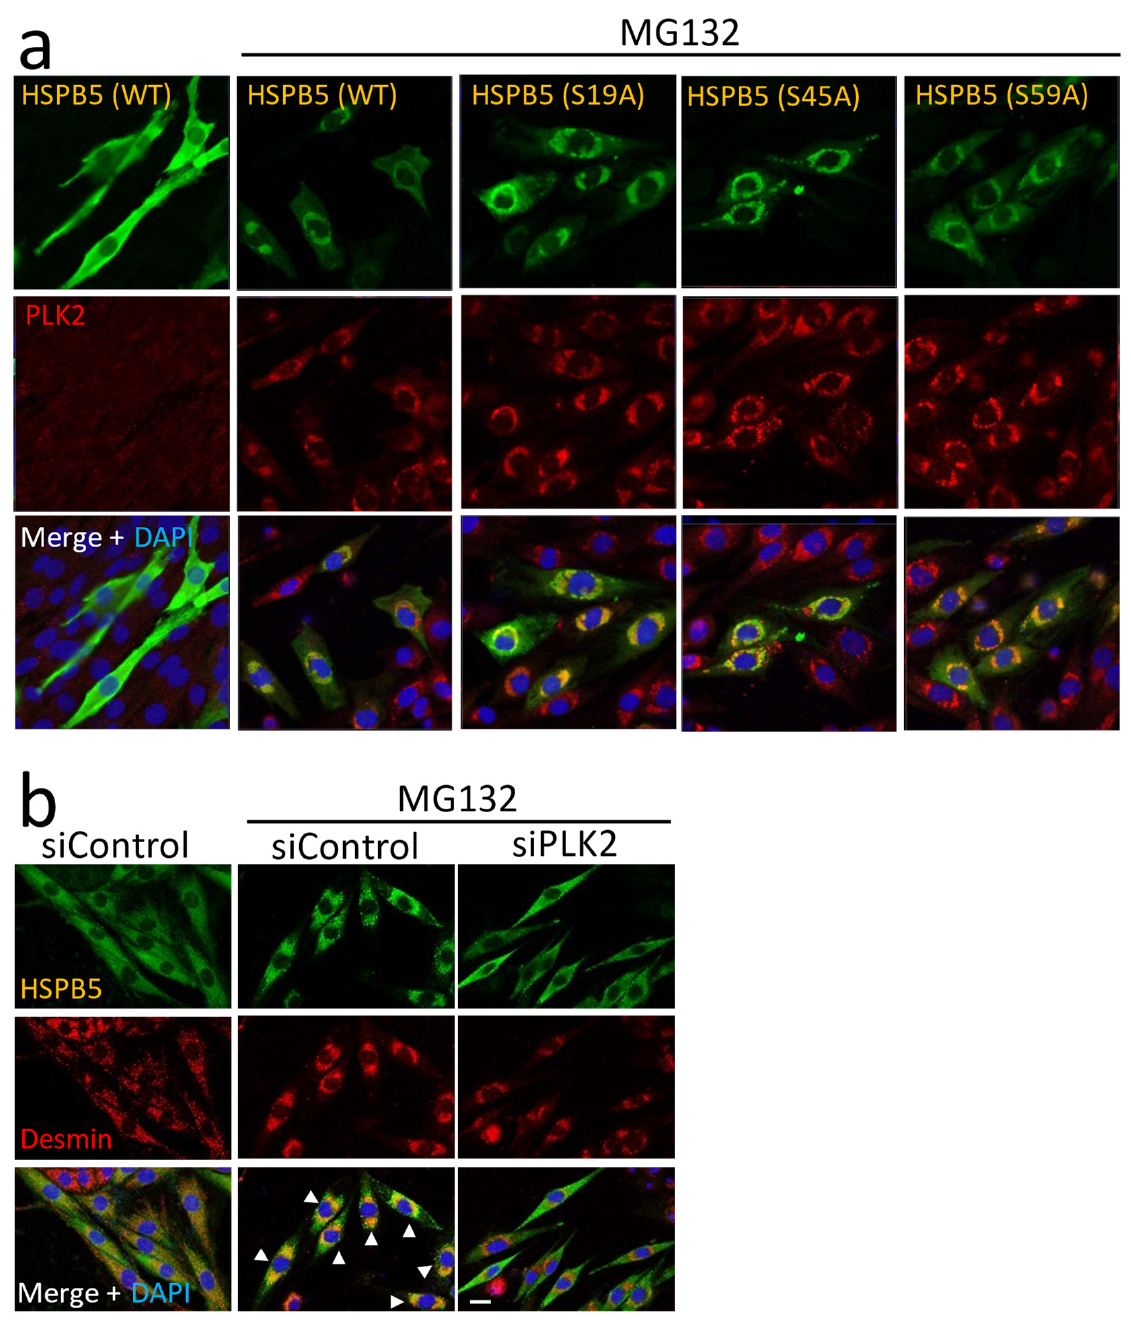
Figure 6. Relationship between phosphorylation and subcellular localization of HSPB5. ( a ) Localization of overexpressed recombinant HSPB5 and endogenous PLK2. After 5 µ M MG132 treatment (24 h), FLAG-tagged HSPB5 and endogenous PLK2 in undifferentiated L6 cells were immunofluorescently stained with anti-tag and anti-PLK2 antibodies. ( b ) Effect of PLK2 on localization of HSPB5 and desmin protein. Endogenous HSPB5 and desmin were immunofluorescently stained with anti-HSPB5 and anti-desmin antibodies. Undifferentiated L6 cells were transfected with siRNA to knockdown PLK2. After differentiation (48 h), L6 myotubes were treated with MG132 for 24 h. White arrowheads indicate cells with colocalization of HSPB5 and desmin at perinuclear ER region. Scale bar indicates 20 µ m.